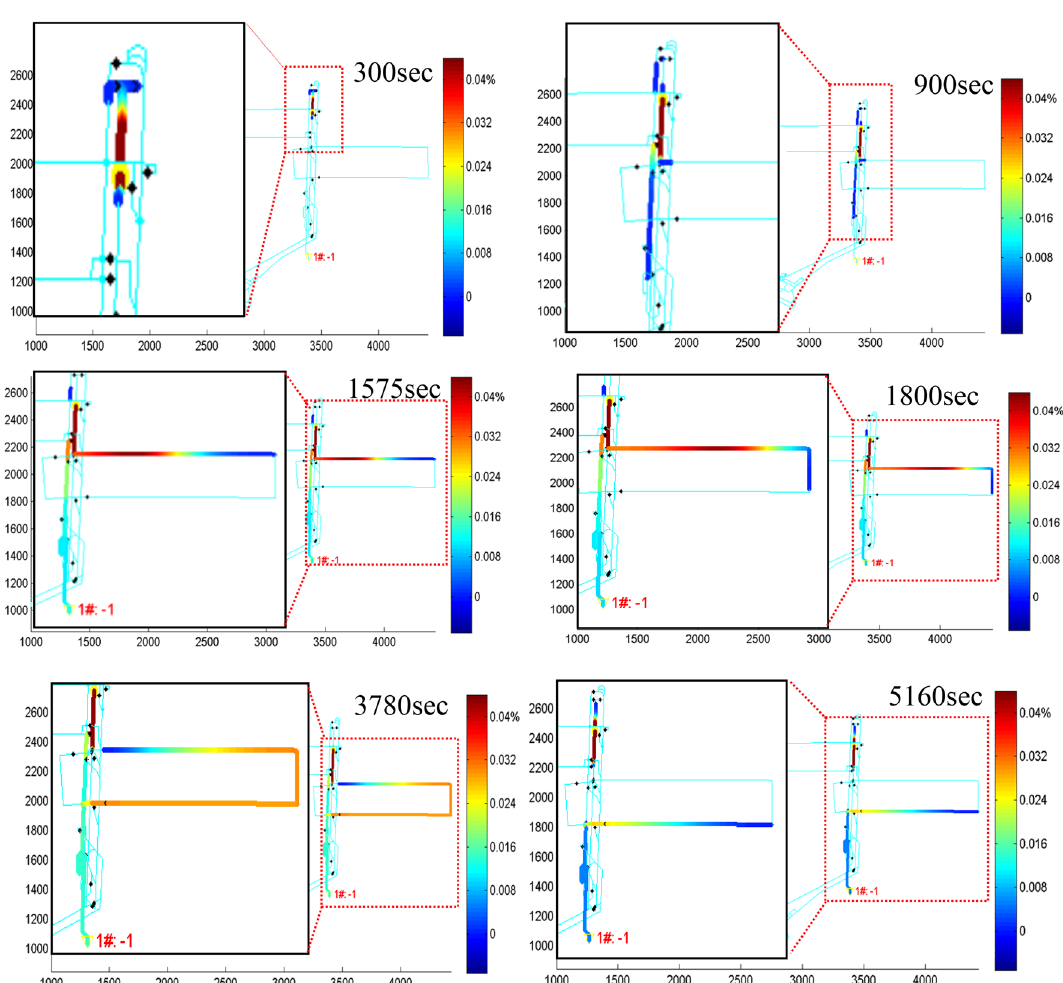
Figure 8. Process of CO gas spreading in the mine at the 13,006 working face due to downstream wind flow